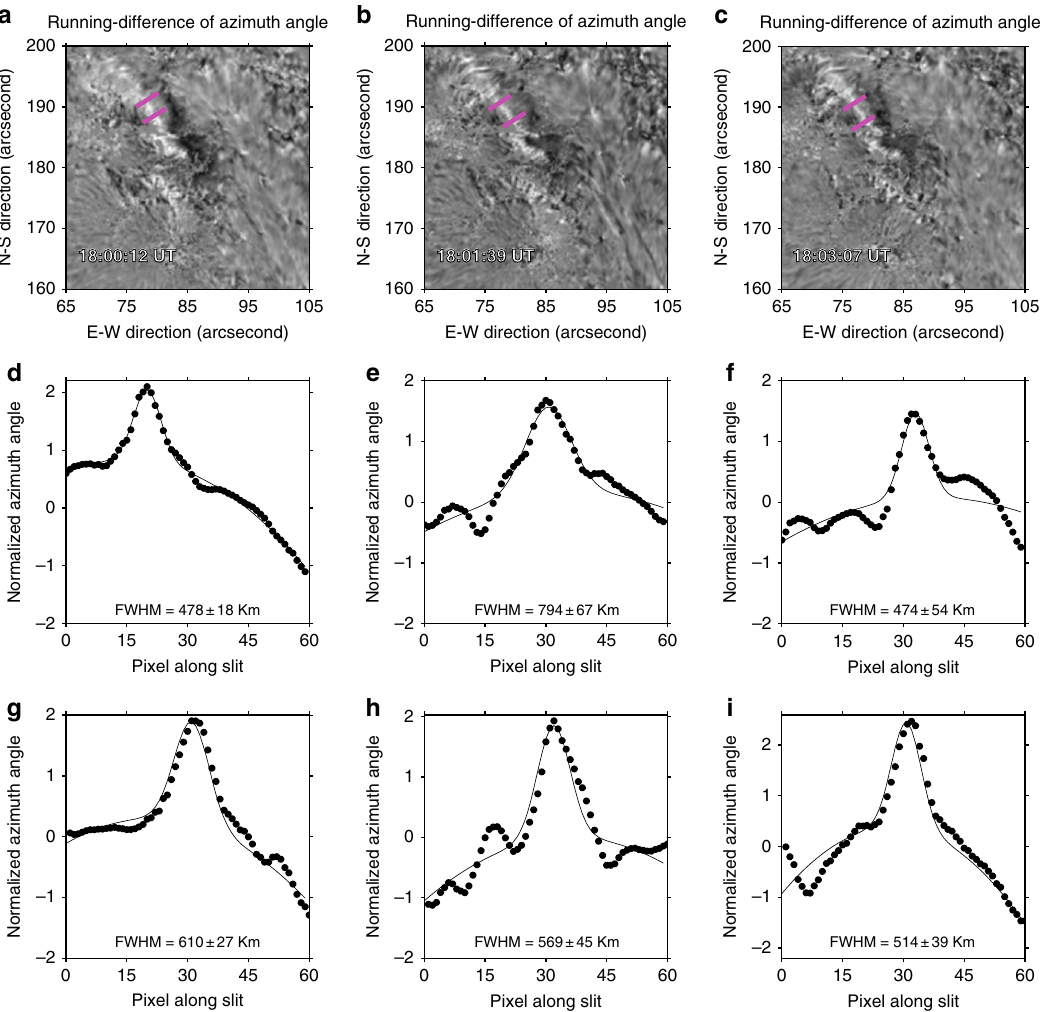
Fig. 2 Characteristic sizes of the region of azimuth angle deviation. a – c Sparse running difference maps of azimuth angles, taken at three representative times. d – f Azimuth angle pro fi les along the top slit shown in each image in ( a – c ) and the corresponding Gaussian fi ts. g – i Azimuth angle pro fi les along the lower slit shown in each image ( a – c ) and the corresponding Gaussian fi ts. The FWHM, derived from the fi tting, is used as the ribbon width of azimuth change, which is about 570 km on